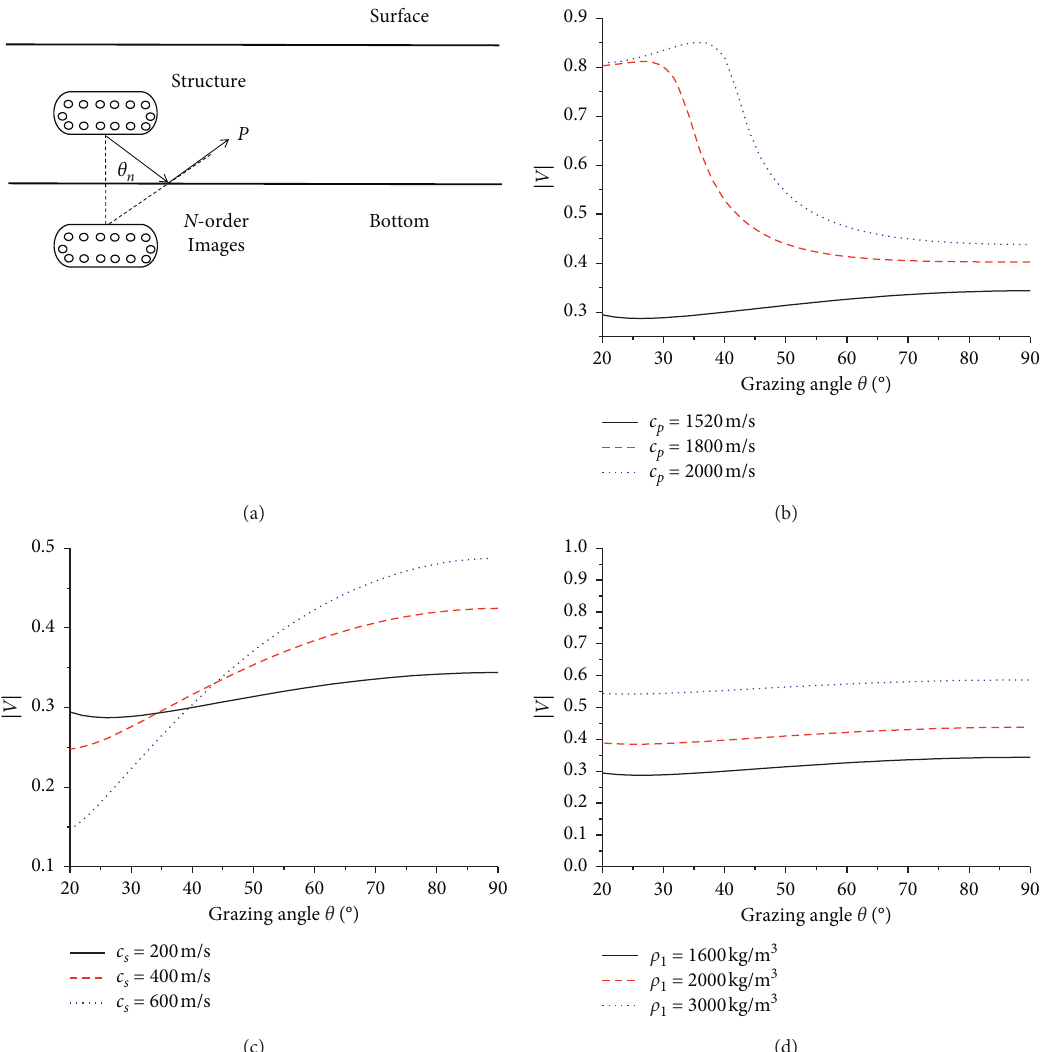
� 1600m/s , ρ � 1600kg/m 3 ). (d) The | V | − θ 1 1